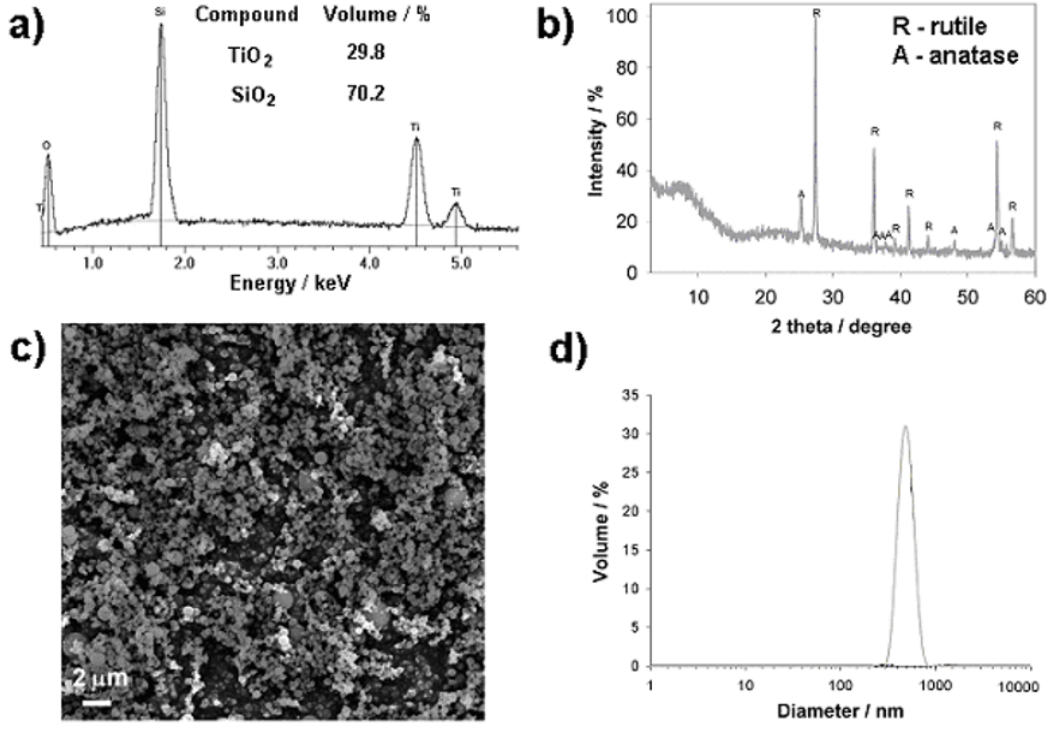
Figure 1. Structural characterization of the hybrid TiO